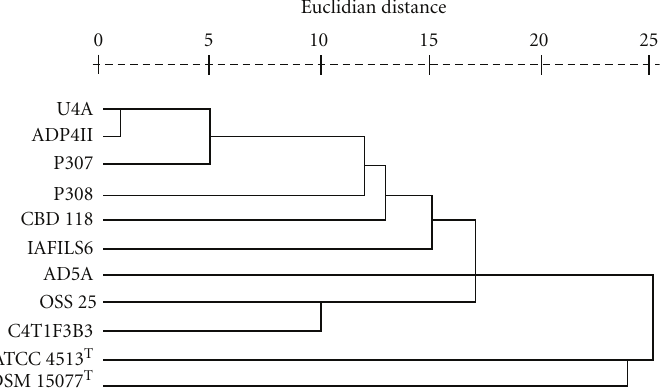
Figure 4: Dendrogram based on cluster analysis of di ff erential phenotypic characters among 11 Bacillus strains including B. circulans ATCC 4513 T and B. nealsonii DSM 15077 T , in Euclidian Distance